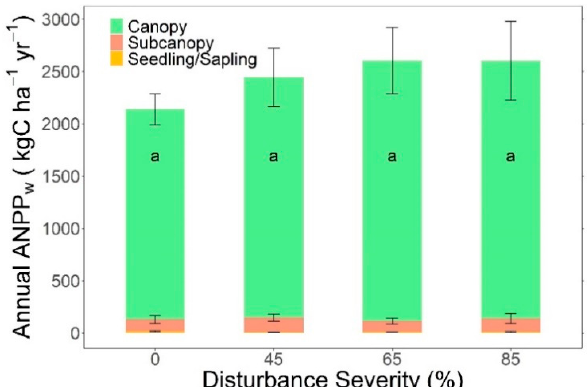
Figure A1. The contributions of upper canopy ( ≥ 8 cm diameter breast height, DBH), subcanopy (<8 cm DBH), and seedling/sapling (below DBH height) stems to annual aboveground wood net primary production (ANPP w ) ( +/ − SE) in the first year following disturbance. Error bars are the SE of annual ANPP w among treatment replicates. Common letters ( a ) signify no significant ( p > 0.05) difference in total (summed across canopy strata) annual ANPP w among disturbance severities. ANPP w ± 1 S.E.